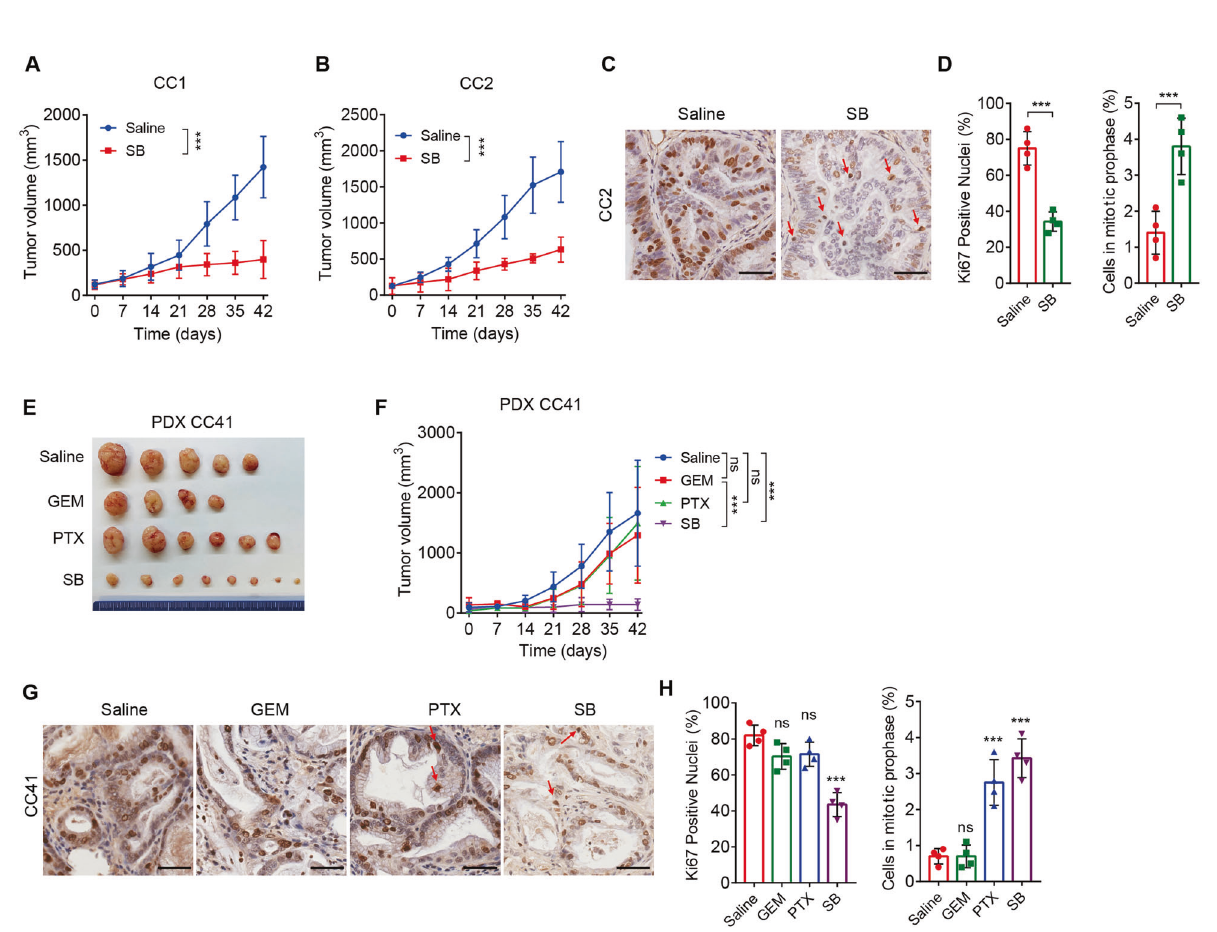
Fig. 6 Tumor suppression resulting from SB743921 treatment in CCA PDX models. A , B Tumor volumes of CC1 and CC2 PDX models. PDX tumor-bearing mice were divided into two groups and treated with SB743921 (5 mg/kg, n = 4 and 3, respectively), or saline ( n = 5 and 3 respectively). C , D Representative images and quanti fi cation of Ki67 staining in CC2 PDX tumors. Arrows indicate mitotic cells and the quanti fi cation of mitotic cells was shown. E Gross images of CC41 PDX tumors. F Tumor volumes of CC41 PDX models. PDX tumor-bearing mice were divided into four groups and treated with gemcitabine (10 mg/kg, n = 4), paclitaxel (10 mg/kg, n = 6), SB743921 (5 mg/kg, n = 8), or saline ( n = 5). G , H Representative images and quanti fi cation of Ki67 staining in CC41 PDX tumors. Arrows indicate mitotic cells and the quanti fi cation of mitotic cells was shown. Scale bars, 50 μ m. Panels A , B , and F were analyzed by two-way ANOVA; Panels D and H were analyzed by the two-tailed unpaired t- test. ** p < 0.01, *** p < 0.001, ns, not signi fi